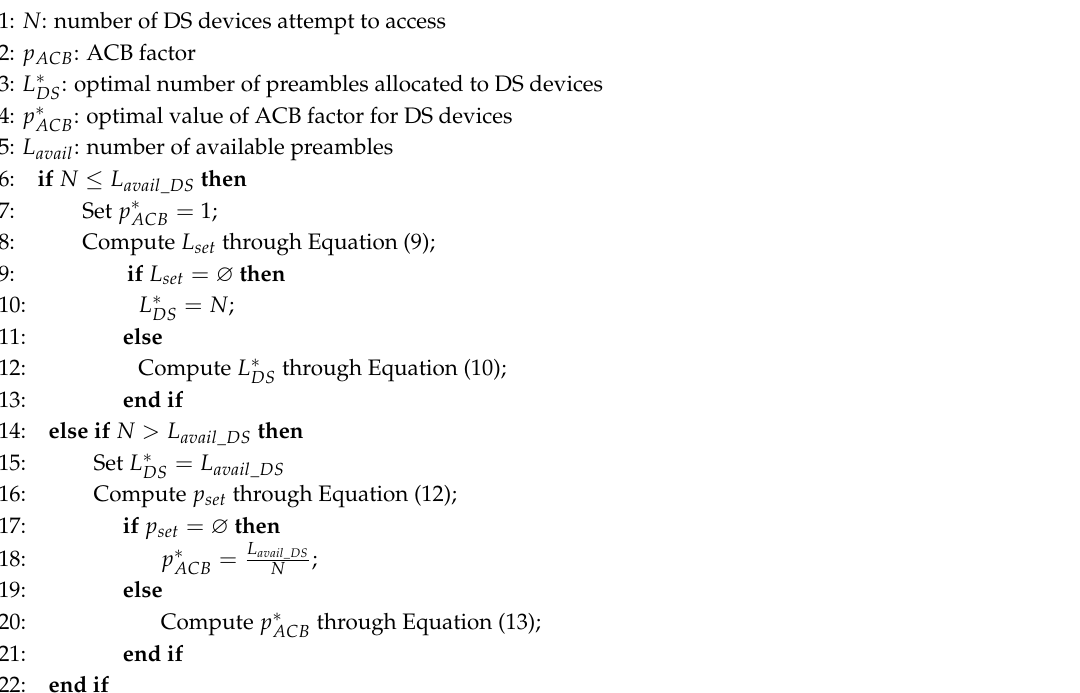
Algorithm 1 Proposed dynamic resource allocation and ACB scheme in a